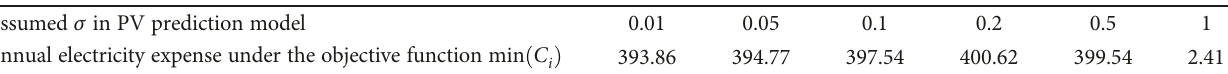
Figure 3: Change of annual consumption on electricity with varied available storage battery capacity. Table 4: Results of annual electricity expense with B = 5 kWh and min C i under di ff erent σ of forecasting PV model. max Assumed σ in PV prediction